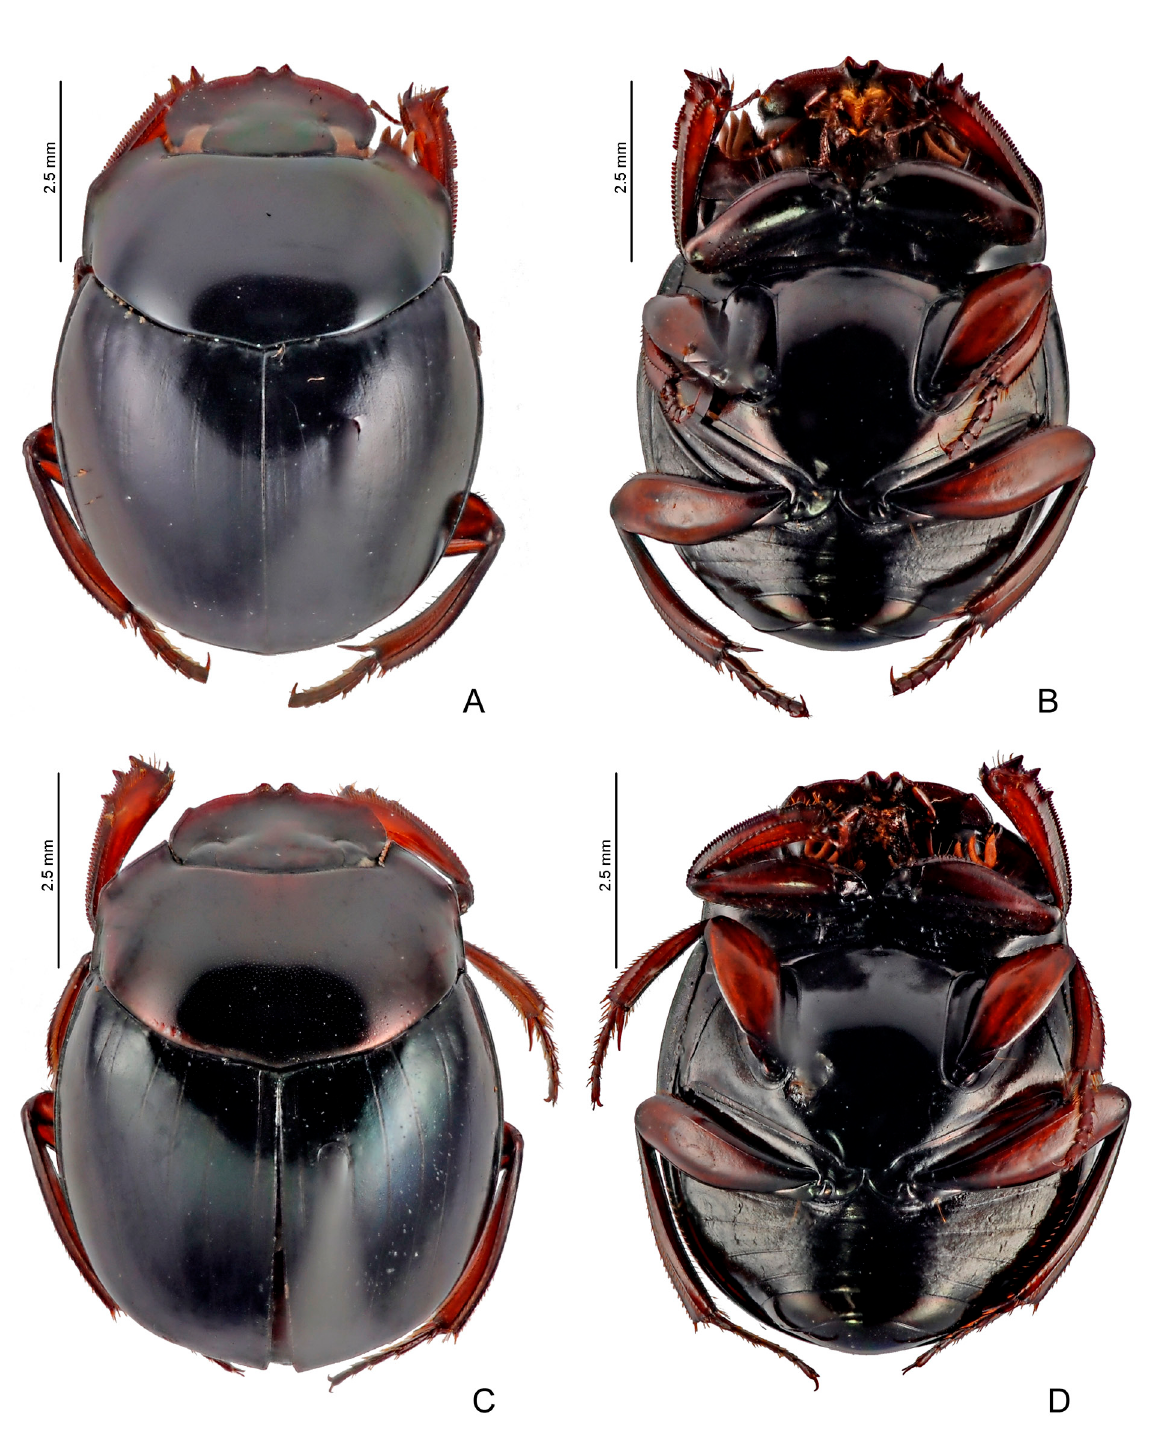
Fig. 38. A–B . Sylvicanthon edmondsi sp. nov. A . Dorsal view. B . Ventral view. C–D . Sylvicanthon attenboroughi sp. nov. C . Dorsal view. D . Ventral